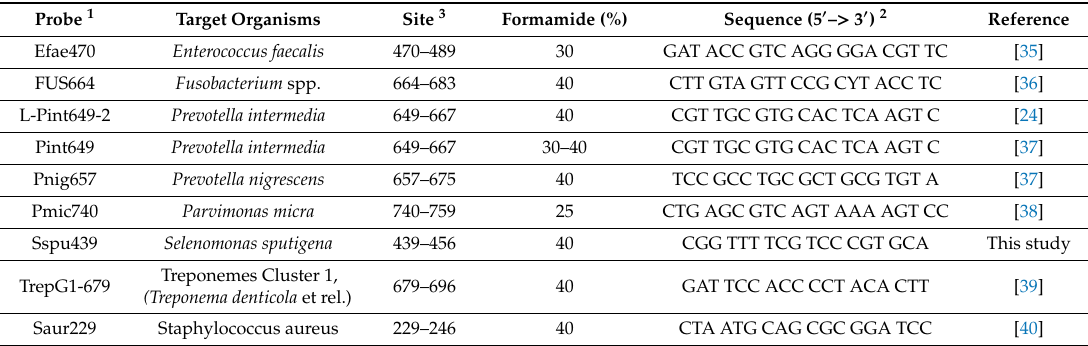
Table 2. Sequence and formamide concentrations for FISH